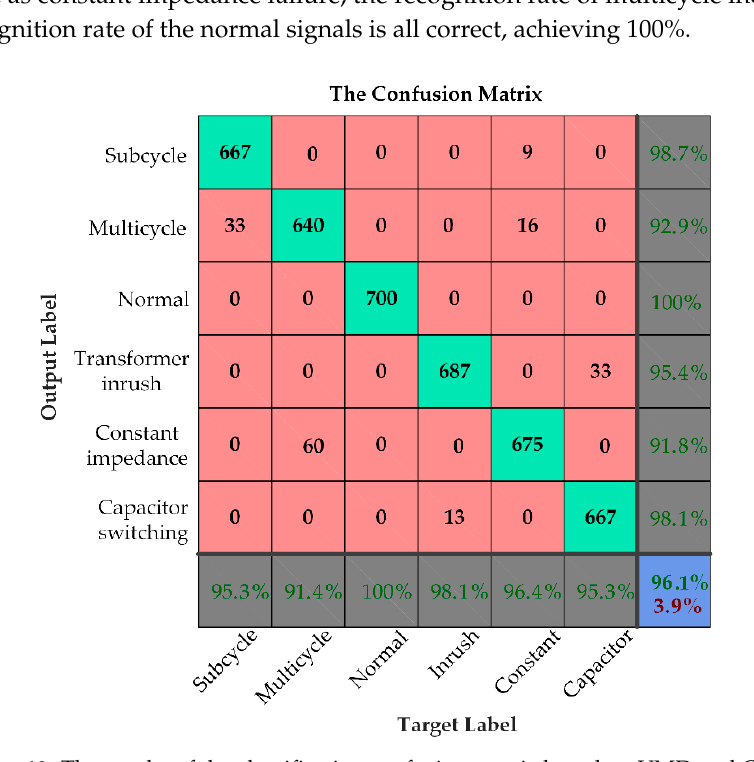
Table 3. Comparison between VMD feature extraction and the original signals. Preprocessing